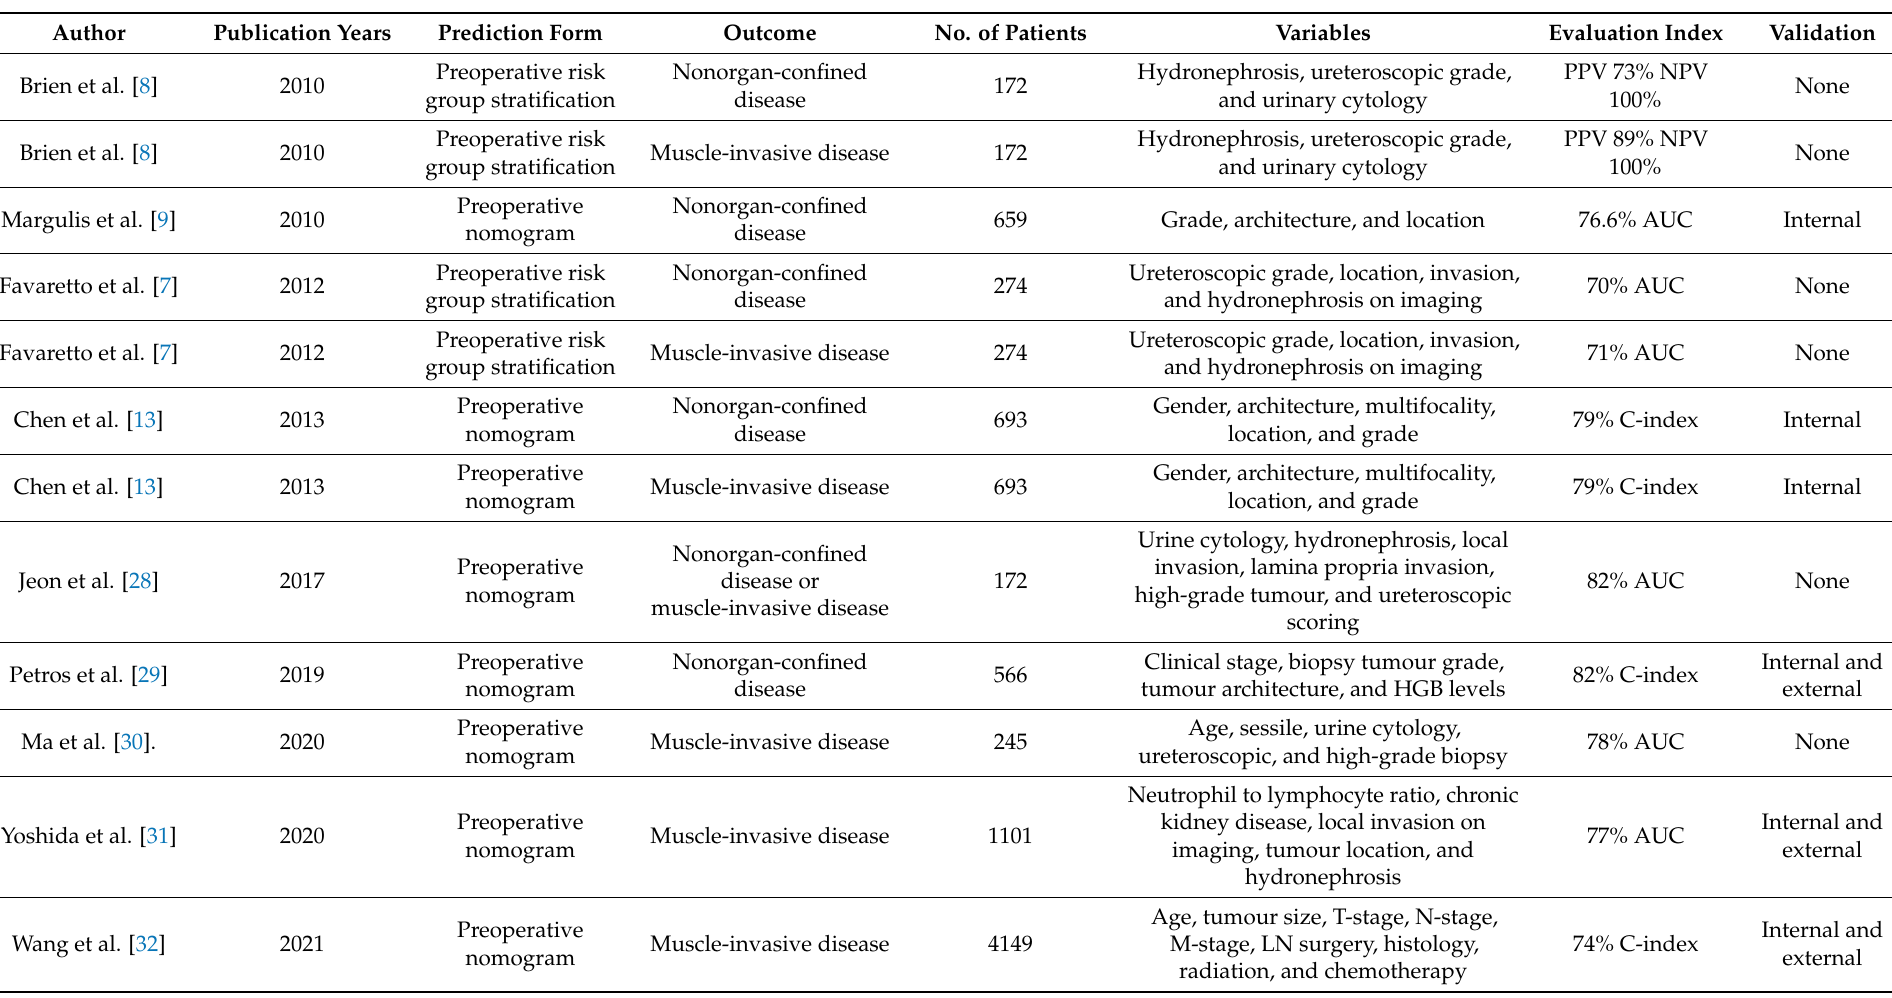
Table 3. Preoperative prediction tools in patients with upper tract urothelial carcinoma. PPV, positive predictive value; NPV, negative predictive value; AUC, area under the curve; HGB,